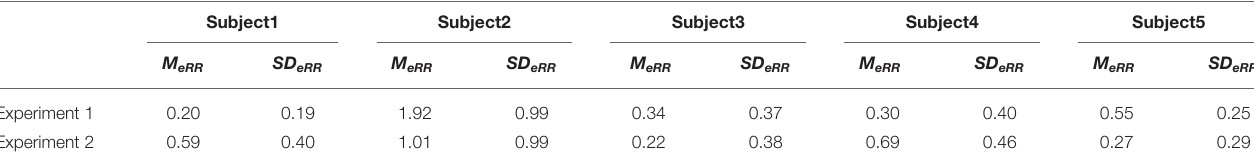
TABLE 4 | Mean and standard deviation of the RR estimation error between the estimated RR and the reference RR of one-subject experiments